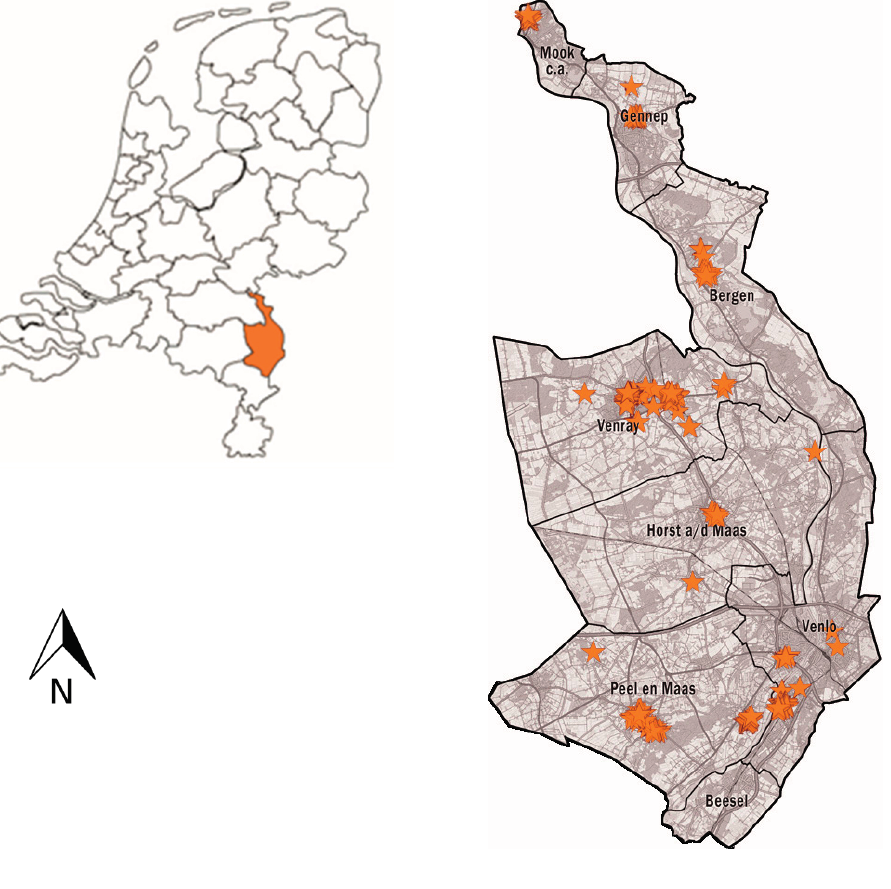
Figure 1. Map of Noord-Limburg and sampling